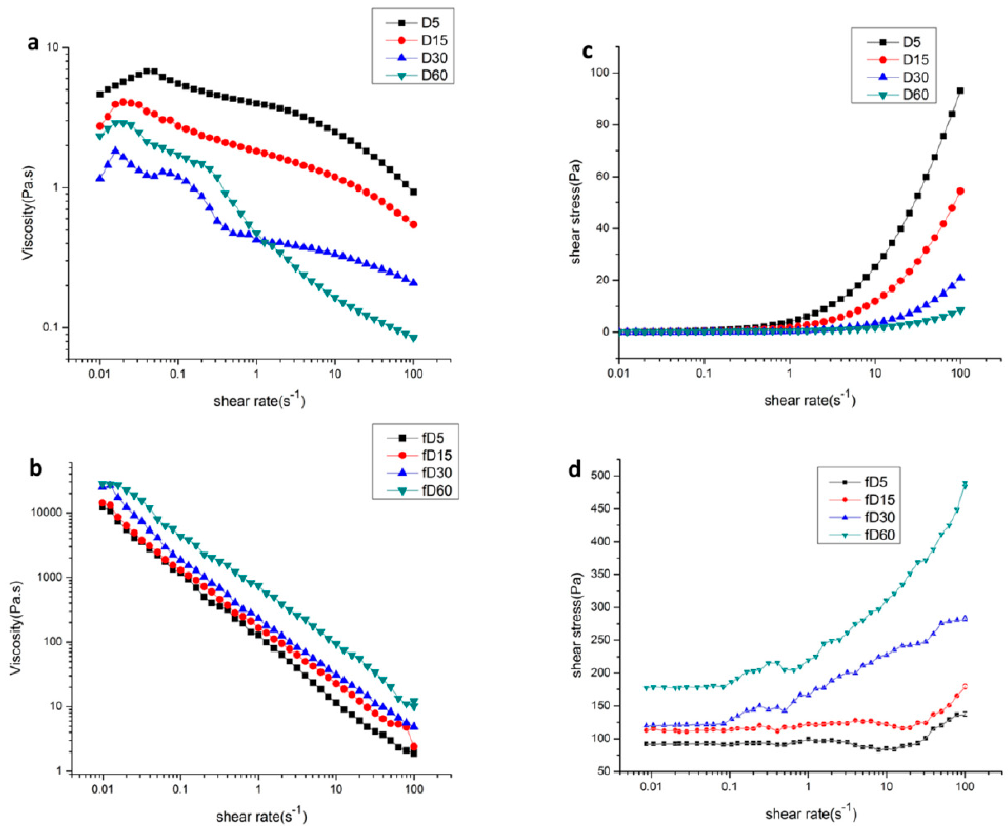
Figure 7. The steady state flow curves of 1% KGM sols with different sonication time before and after freezing dealt.